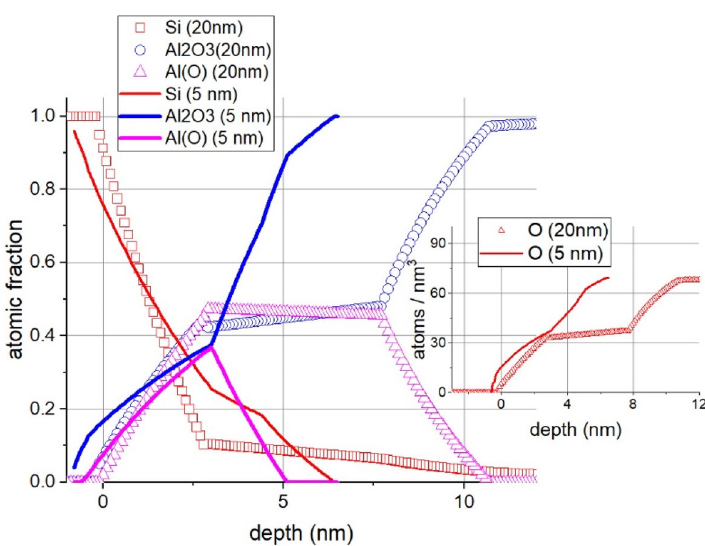
Figure 5. The concentration distributions after electron irradiation at 500 °C (5 keV, I = 500 nA, 20 h ) of samples 5 nm and 20 nm Al 2 O 3 /Si substrate. The position of the original Al 2 O 3 /Si interface is at 0 nm, the positive direction is toward the layer (for clarity only the altered part is shown). The denotations Al 2 O 3 , Si, AlO x in the legend stand for pure Al 2 O 3 , metallic Si and Al suboxide, respectively. The insert shows the O depth profile in atoms/nm 3